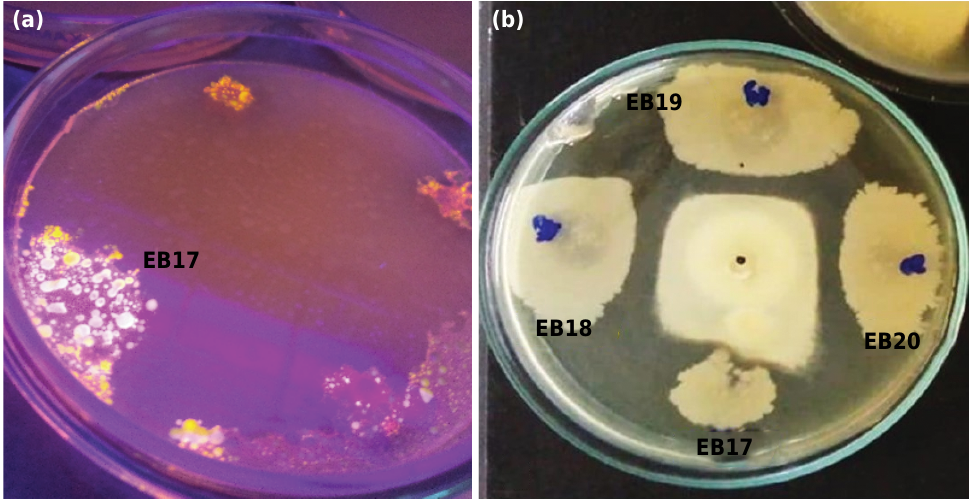
Figure 3. Indirect plant growth promoting mechanisms of Bacillus isolates. Lipase production (a). Inhibition of S. cepivorum (b)